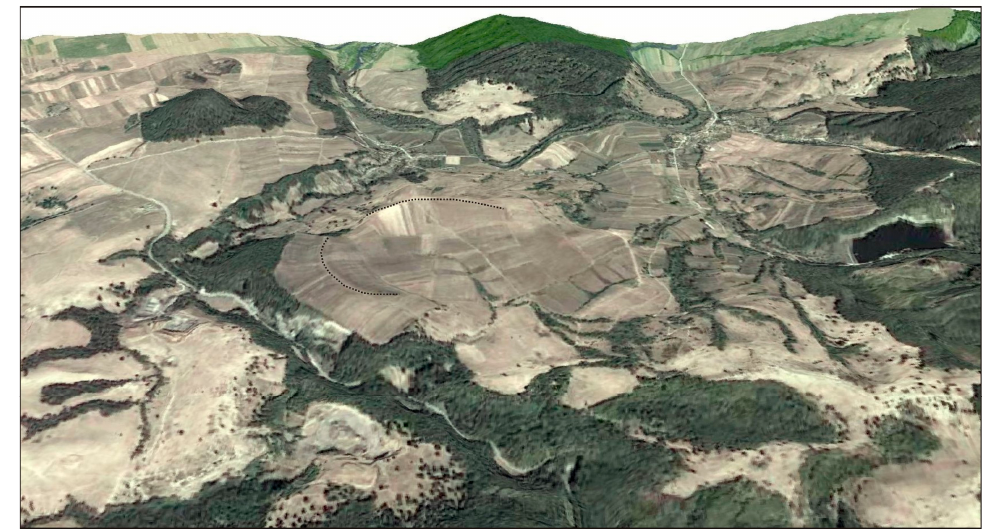
Figure 15. Negative landform in the Per ș ani Mountains alkali basaltic volcanic field: a maar-type depression is still recognizable in the center of the image (enhanced rim). Google Earth capture.